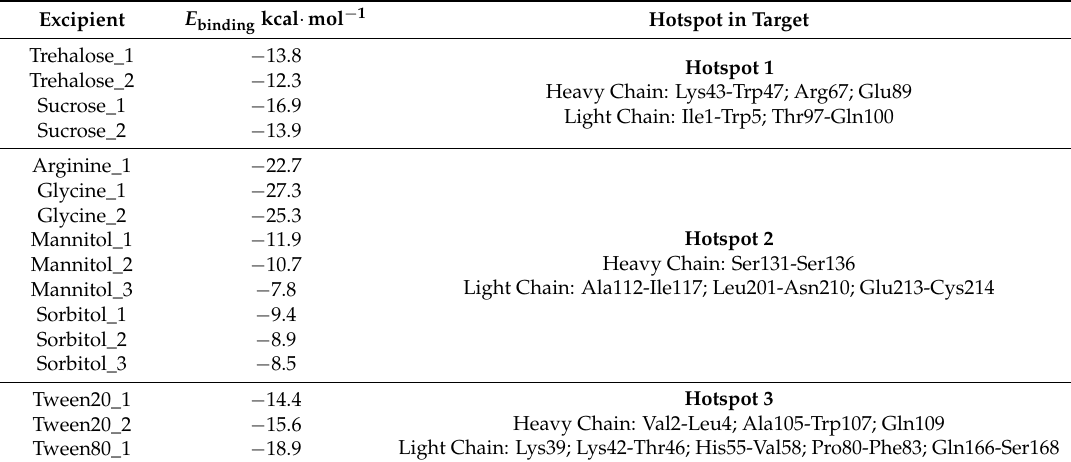
Figure 10. Frontal ( left ) and side ( center ) views of the three hotspots for A33–excipient interaction identified. A33 residues involved in each hotspot highlighted in yellow ( right ). A33 is represented as ribbons with the heavy chain in dark blue and the light chain in green. The representative structures of the excipients are displayed in CPK, trehalose—black; sucrose—pink; arginine—light green; glycine—orange; manitol—salmon; sorbitol—dark green; polysorbate 20—magenta and polysorbate 80—purple. Table 5. Description of the three hotspots identified for A33-based on the interaction with a set of commercial excipients.